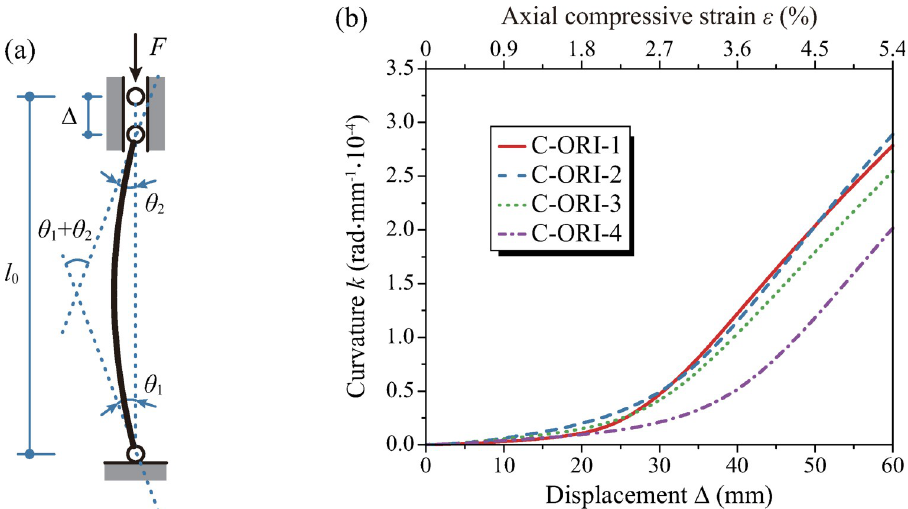
Fig 12. Rotations at ends. (a) illustration of rotations; (b) curvatures during loading process.